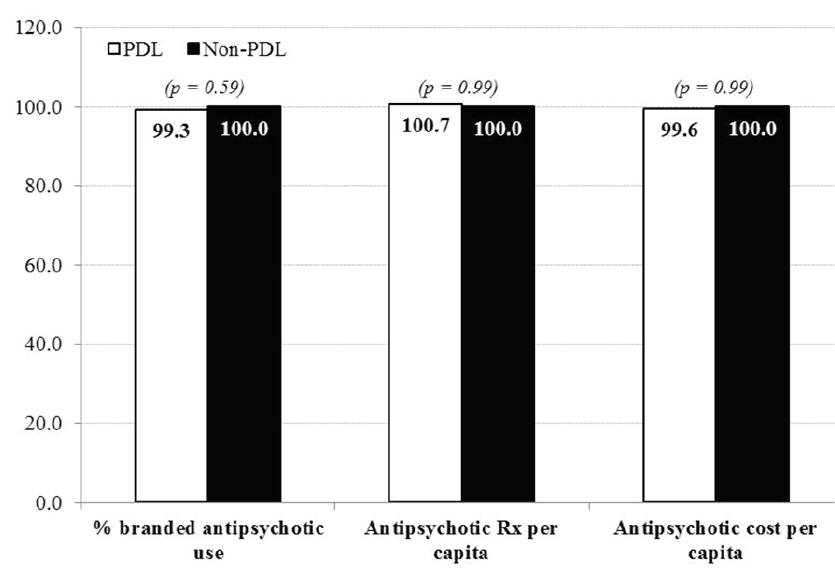
Figure 1. Estimated Antipsychotic Costs and Utilization per Capita by State Medicaid Antipsychotic Category Management Approach (Non-PDL states average normalized to 100)